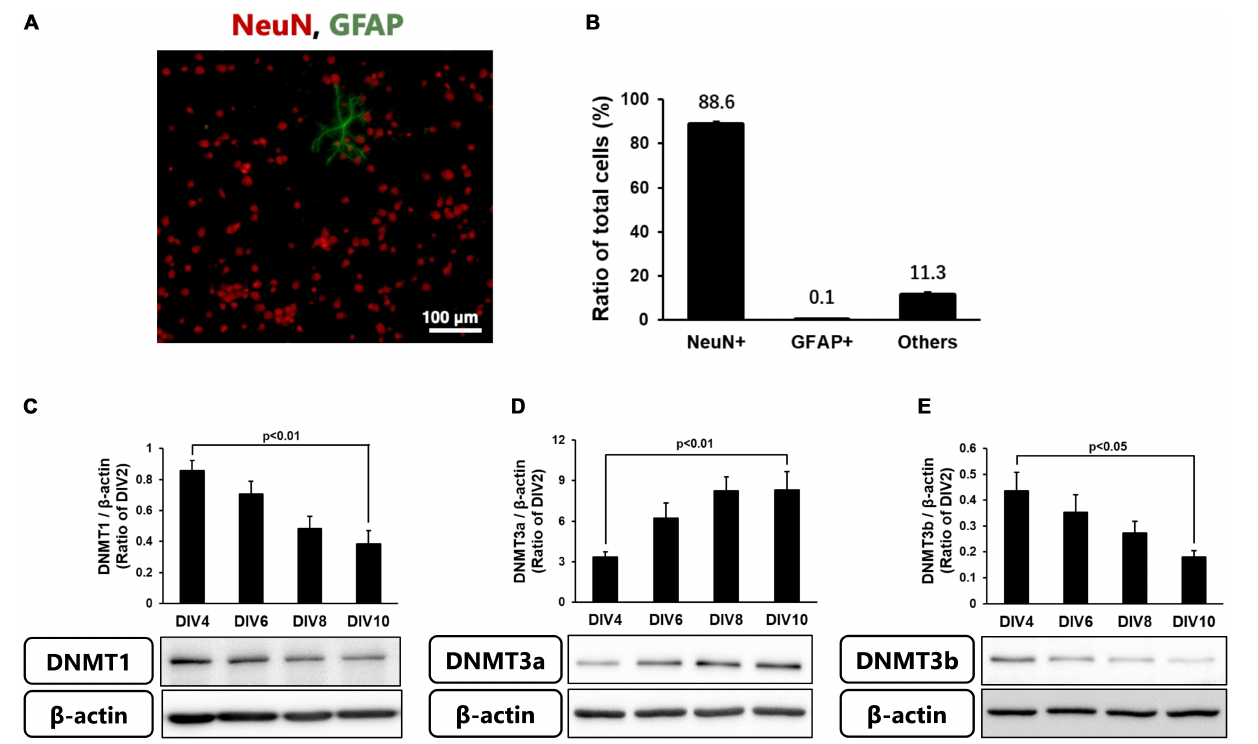
FIGURE 3 | (A) Representative images of double-staining for NeuN (Red) and GFAP (green) in cortical neurons in primary culture at 10 DIV. (B) Ratio of NeuN- and GFAP-positive cells to total cells (Hoechst-positive cells) at 10 DIV. Images of random four areas (each area of 1.3 mm 2 ) of each well were taken, and 1,195–1,320 cells were counted in each well. The scale bar shows 100 µ m. Results are the means ± SD ( n = 4 independent experiments). (C–E) Changes in the protein levels of DNMT1 (C) , DNMT3a (D) , and DNMT3b (E) with time in culture. These DNMTs and β -actin bands were scanned, and the scanned bands were normalized by DIV2 cells on the same blot. β -Actin was used as a loading control. Results are the means ± SD ( n = 5–13 independent experiments).